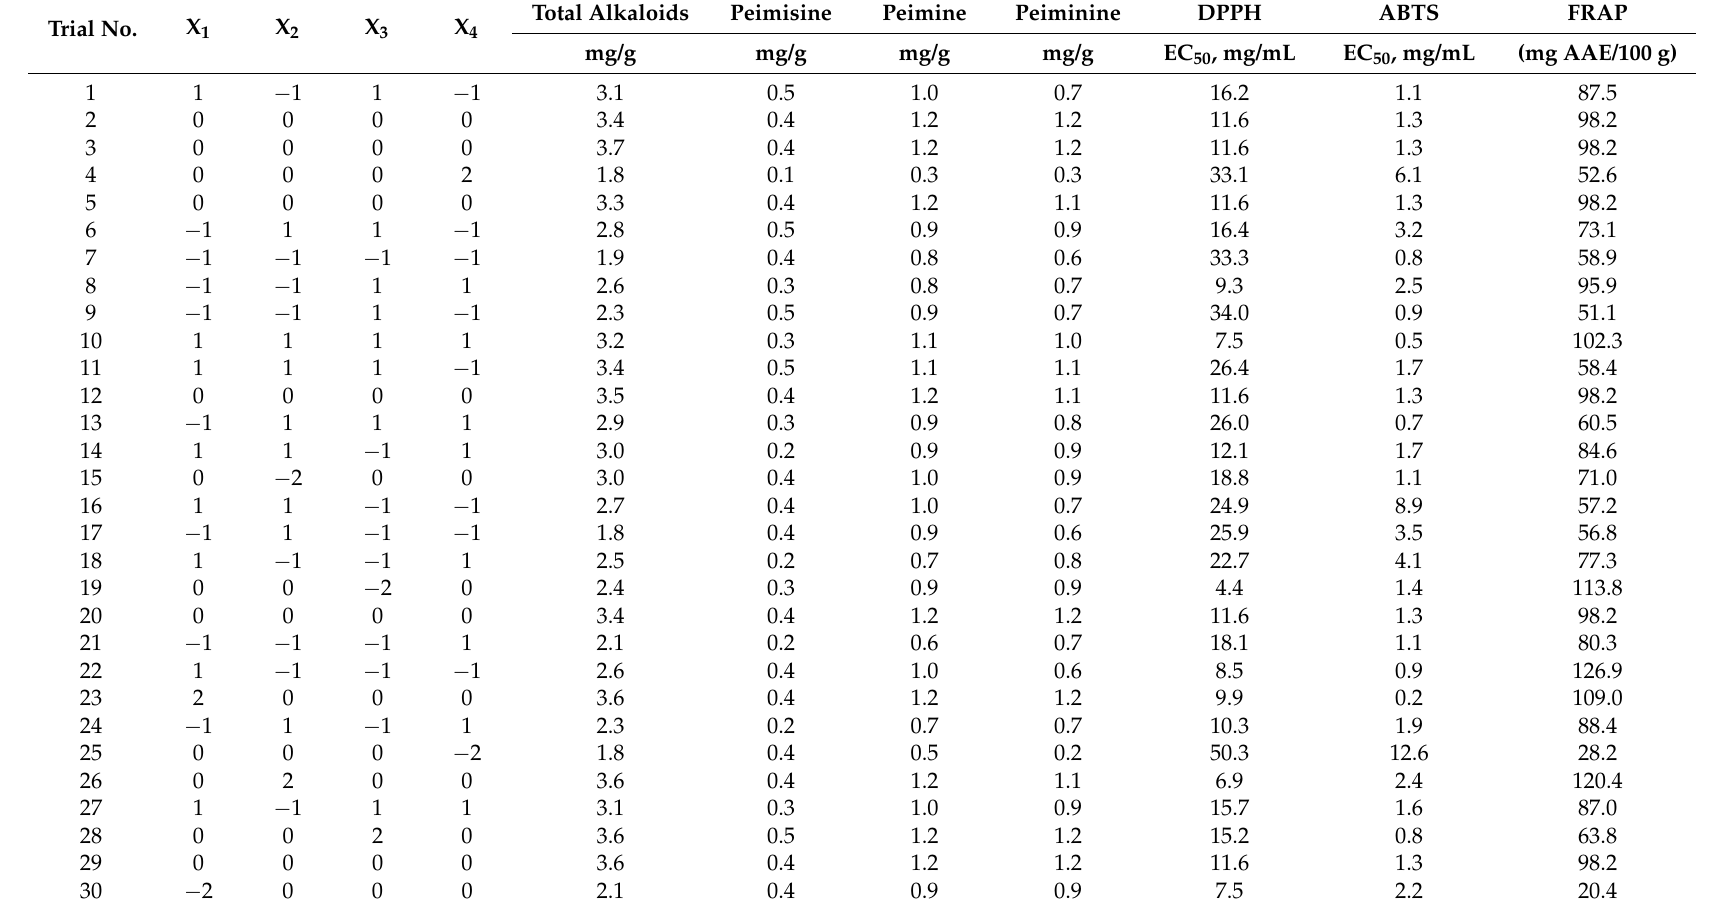
Table 1. CCD experimental design for the yields of total alkaloids, Peimisine, peimine and eiminine, as well as their antioxidant power. Trial